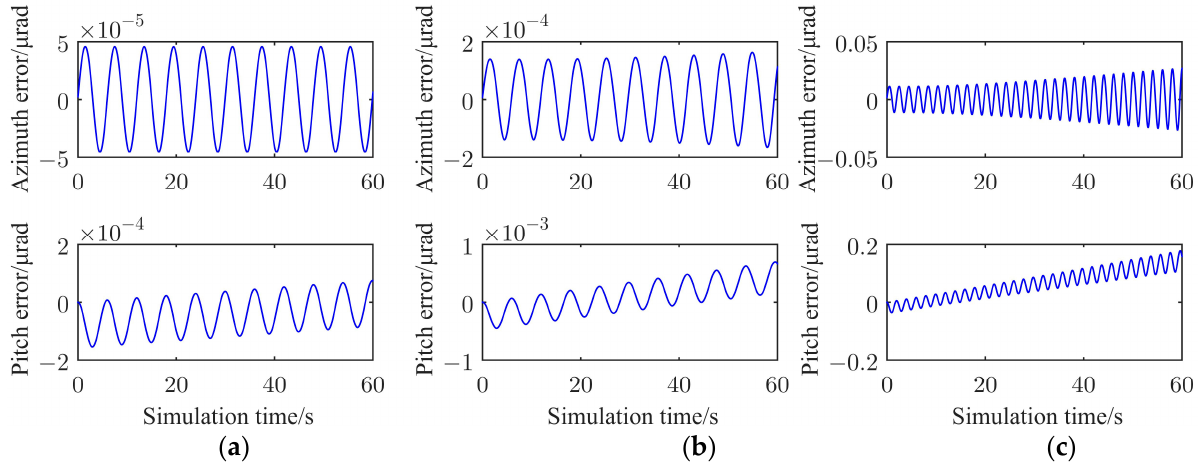
Figure 10. The error curve of the calculation of the indirect numerical calculation method in the